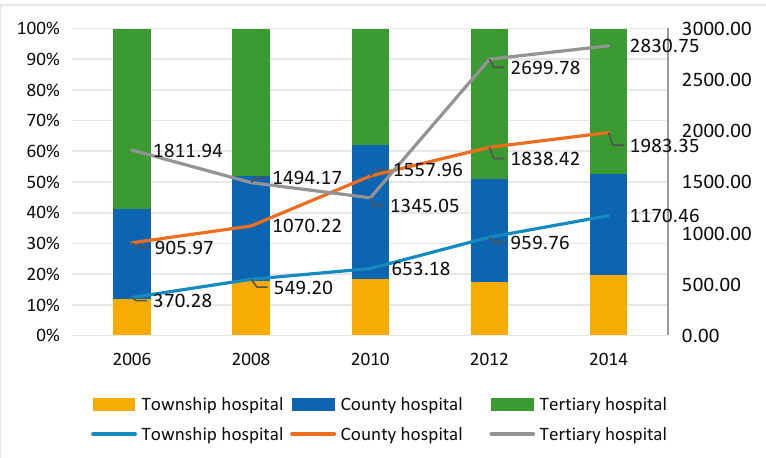
Figure 3. The reimbursement per capita in different levels of medical institutions (¥). The lines show the adjusted data of reimbursement in different levels of medical institutions. The bar chart shows the distribution of the proportion of each level reimbursement in total expense.